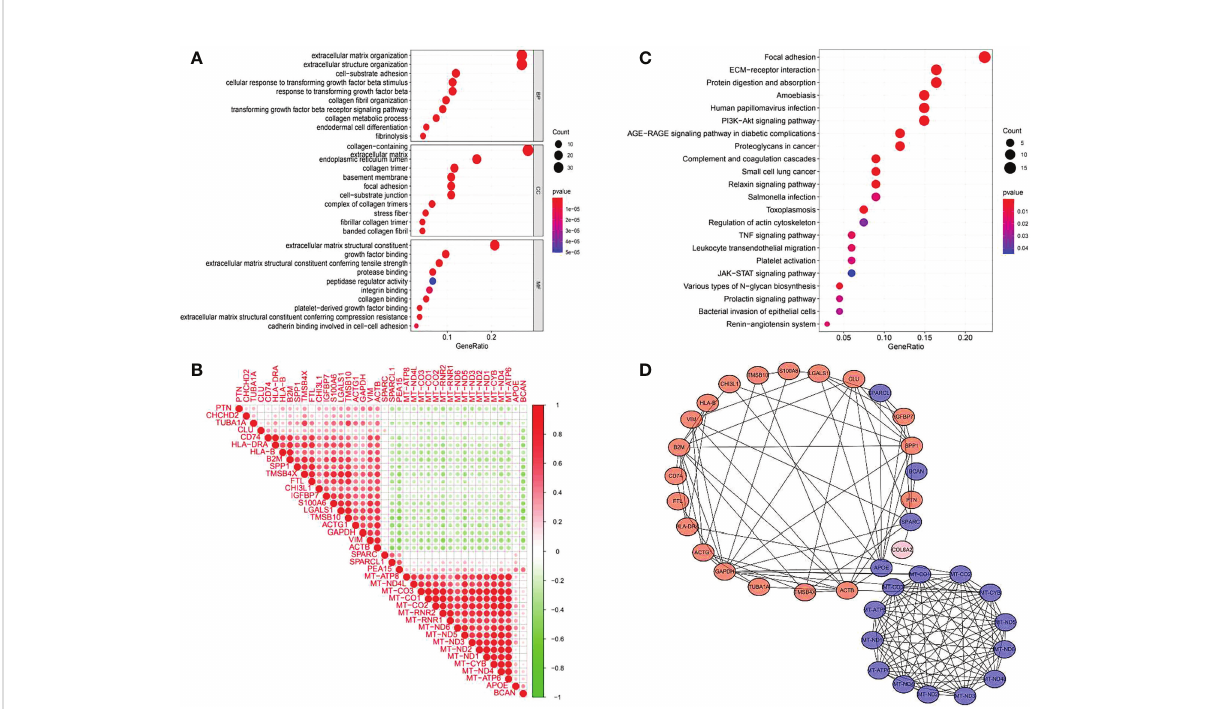
FIGURE 6 GO, KEGG enrichment analysis and gene co-expression of COL6A2. (A) GO enrichment analysis showed that the expression of COL6A2 was related to biological functions such as extracellular matrix organization, collagen-containing, and extracellular matrix structural constituent. (B) KEGG enrichment analysis showed that the expression of COL6A2 was related to the pathway functions such as Focal adhesion, ECM-receptor interaction, and Human papillomavirus infection. (C) Co-expression heat map of COL6A2 related genes, red, positive correlation, green, negative correlation. (D) Protein interaction network, red, upregulation, blue,